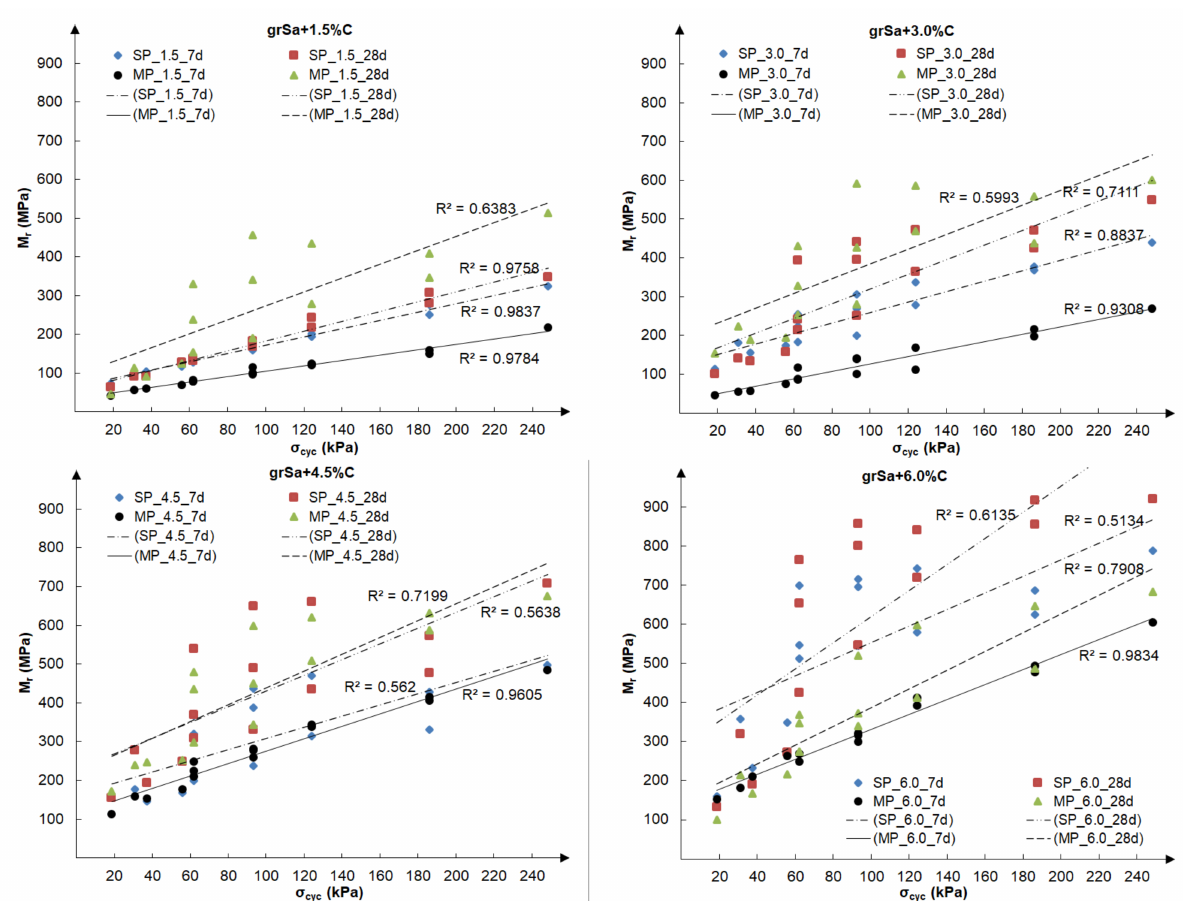
Figure 9. The results of final resilient modulus vs. cyclic applied axial stress obtained for samples compacted by the SP and MP methods after 7 and 28 days of curing for the various cement